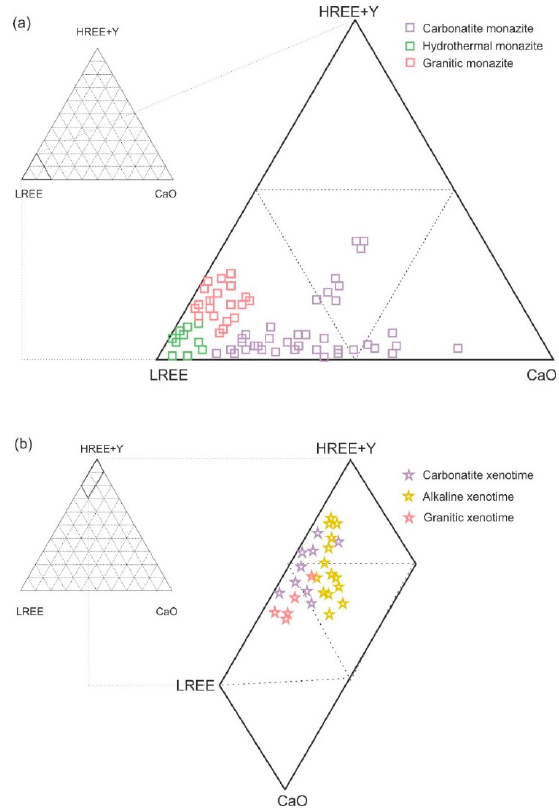
Figure 20. Compositions of monazite ( a ) and xenotime ( b ) in (LREE)–(HREE + Y)–Ca ternary diagrams (mol %); from different types of REE deposits and occurrences in Finland. In the REE deposits of occurrences of Finland, bastnäsite and synchysite are the most common Ca-REE fluorocarbonates and they also show compositional variation according to the conditions of their crystallization (Figure 21a). Based on the EPMA data, bastnäsite with low Ca + Sr contents, ranging from 0.1 to 1.1 wt % CaO + SrO (hydrothermal), 2.0 to 7.3 wt % CaO + SrO (carbonatite), 0.1